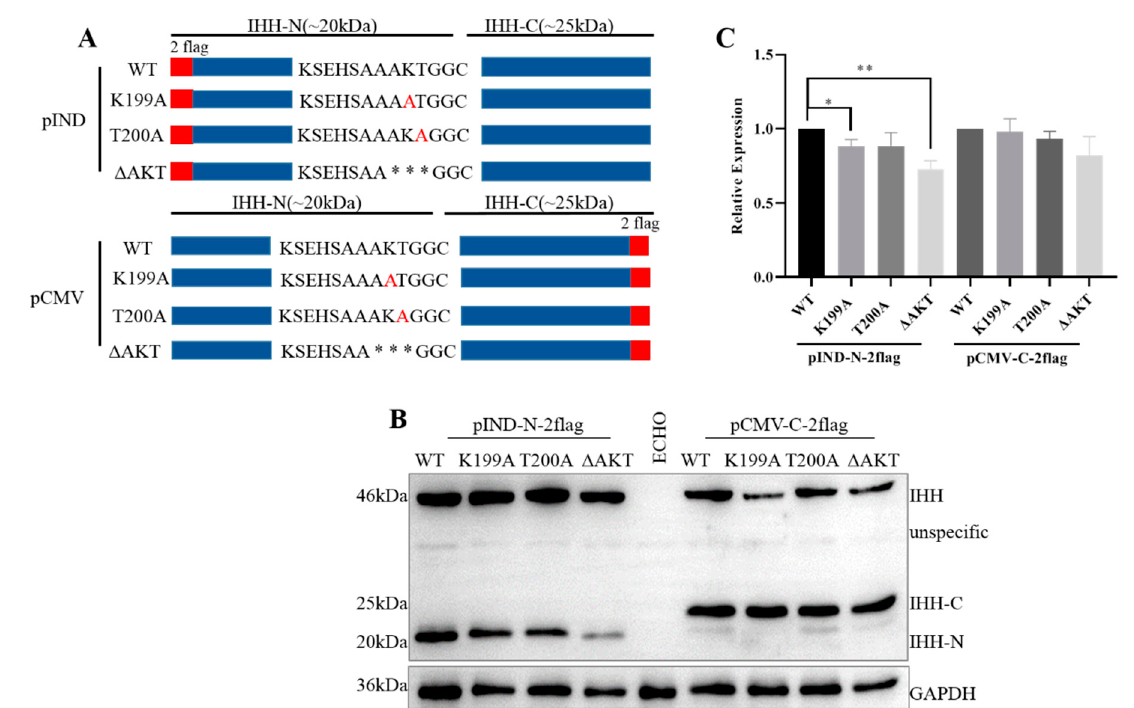
Figure 6. A198, K199, and T200 affect the stability of IHH-N. ( A ) Schematic of point mutations and truncations. Red letters indicate point-mutation amino acids; * truncated amino acids. ( B , C ) Western blot and statistical analysis showed that the expression of point mutations were roughly identical to those of WT. After A198, K199, and T200 were deleted, the normal expression of IHH-C revealed that the self-cleavage was not affected, whereas the decrease in IHH-N indicated that the stability may be affected. Data are mean ± s.e.m, n = 4, * p < 0.05, ** p < 0.01.